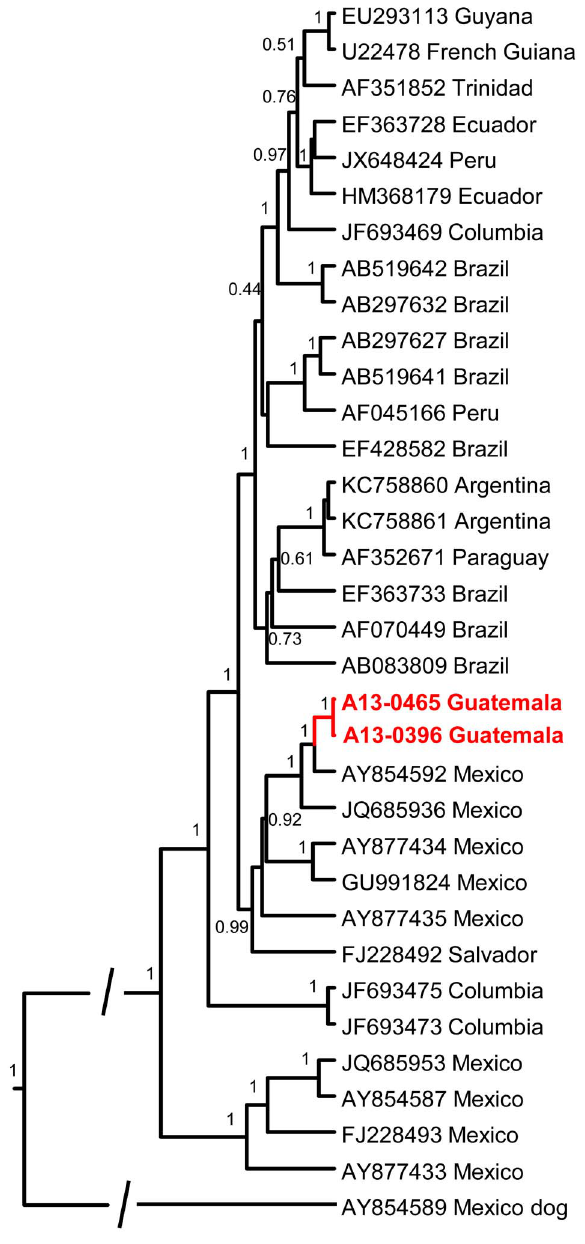
Figure 2. Maximum clade credibility tree of rabies viruses based on complete nucleoprotein (N) gene sequences. Posterior probabilities are shown for key nodes. Mexico dog RABV was used as an out-group. Novel sequences generated from the CNS material of two rabid vampire bats in this study are shown in red.